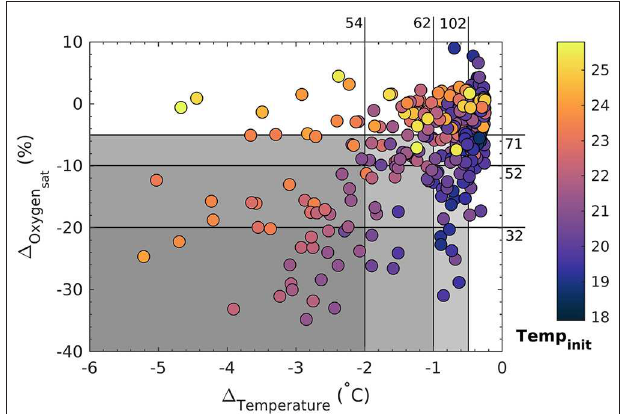
FIGURE 3 | Temperature and oxygen saturation drops in the context of initial temperatures. Measured temperature and concomitant oxygen saturation changes during events of rapid and sustained drops at three temperature and oxygen intensity ranges (gray). Shown are all events with a temperature drop larger than 0.25 ◦ C, while the color code denotes initial temperatures. The numbers on the top and to the right are a count of the events inside each respective range (see text for details).